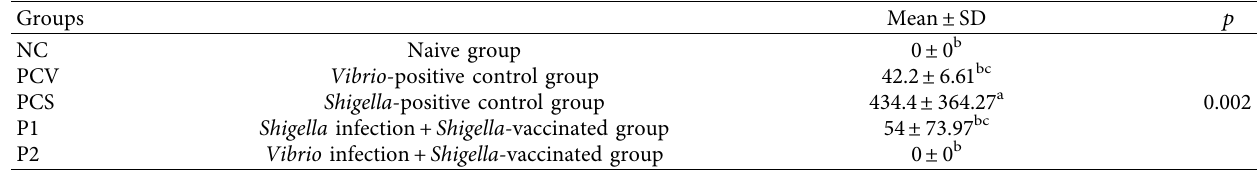
Figure 4: The graph result of weighting every piece of intestinal ligated in the sample. Table 1: The result of the number of colony-forming units in the five groups.